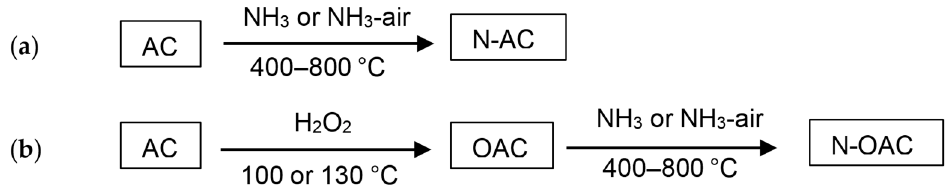
Figure 1. Preparation procedures of ( a ) nitrogen-doped activated carbon (N-AC) and ( b ) nitrogen- doped oxidized activated carbon (N-OAC).